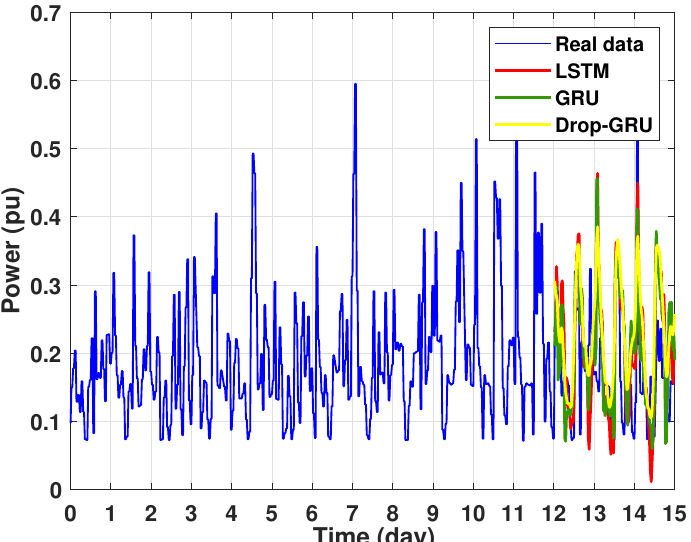
Figure 14. Prediction results of 3 days power consumption.